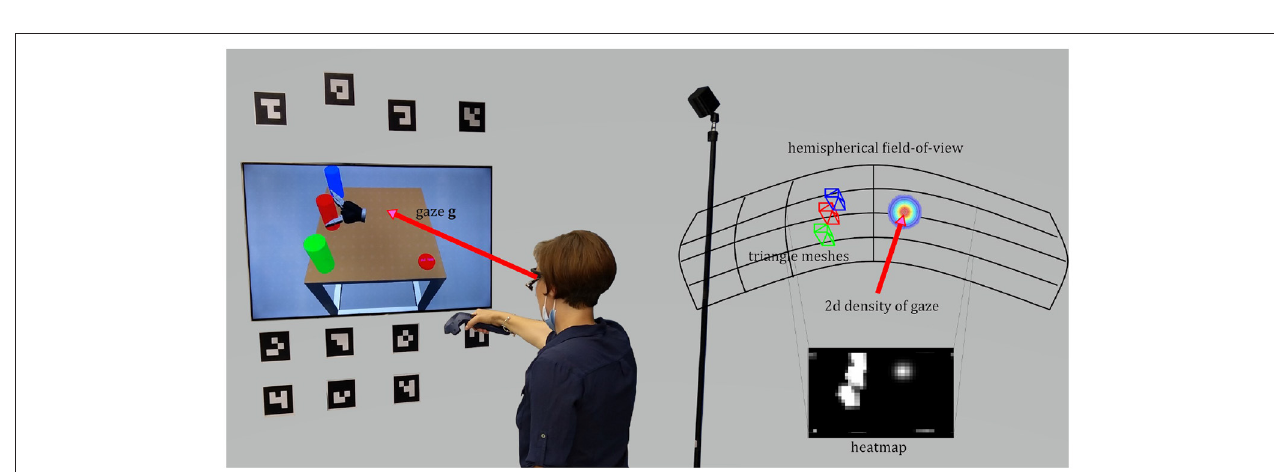
FIGURE 3 | The user’s field-of-view is approximated by a hemispherical heatmap. The density of a 2d normal distribution centered on the point-of-regard represents the gaze and its uncertainty. The surface integral over the triangles of a certain object is the likelihood of this AoI.